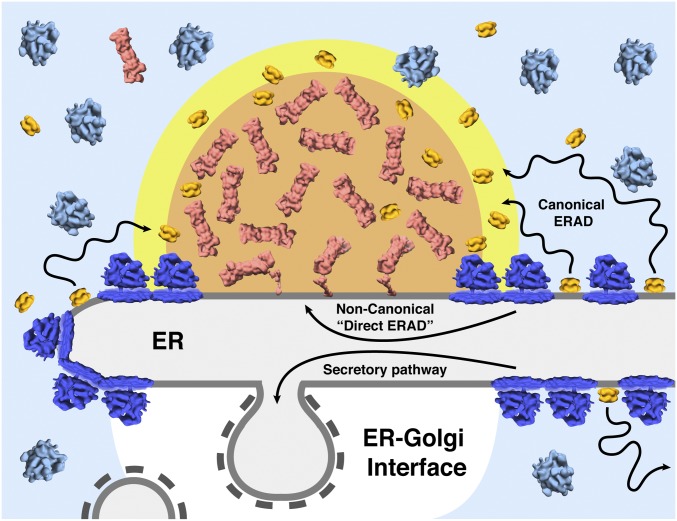
Molecular architecture of non–membrane-bound degradation microcompartments at the ER. Proteasomes (red) and Cdc48 (yellow) cluster together to form concentrated ∼200-nm microcompartments that exclude cytosolic ribosomes (light blue) (Fig. 4 and SI Appendix, Figs. S6 and S7). These microcompartments directly contact small patches on the rough ER membrane (gray) that are devoid of membrane-bound ribosomes (dark blue) and may be enriched in ERAD substrates. The proteasomes closest to the membrane have regulatory caps that are in the substrate-processing conformation and are engaged at their substrate-binding sites with densities emanating from the ER (Fig. 5 and SI Appendix, Fig. S13). Thus, these densities are likely substrates that are undergoing removal from the ER directly by proteasomes (a noncanonical pathway we term “direct ERAD”). Cdc48 complexes are enriched at the microcompartment periphery, where they may be handing substrates to the proteasomes in the final step of the canonical ERAD pathway. Unlike proteasomes, Cdc48 is commonly found all along the ER membrane (82% of ER-proximal proteasomes, but only 20% of ER-proximal Cdc48, are localized to the microcompartments). Therefore, Cdc48 might extract substrates from the ER, then diffuse through the cytosol until it encounters a proteasome, the majority of which are clustered in microcompartments. Cytosolic diffusion of Cdc48, followed by substrate hand-off to proteasomes, could explain the peripheral localization of Cdc48 around the proteasome clusters. The microcompartments may additionally serve as degradation centers for cytosolic proteins. The microcompartments are positioned away from the larger ribosome-free region of the ER where COPII-coated vesicles bud en route to the Golgi. This spatially segregates the ERAD and secretory pathway machinery, and may aid in sorting ER proteins between trafficking and degradation.